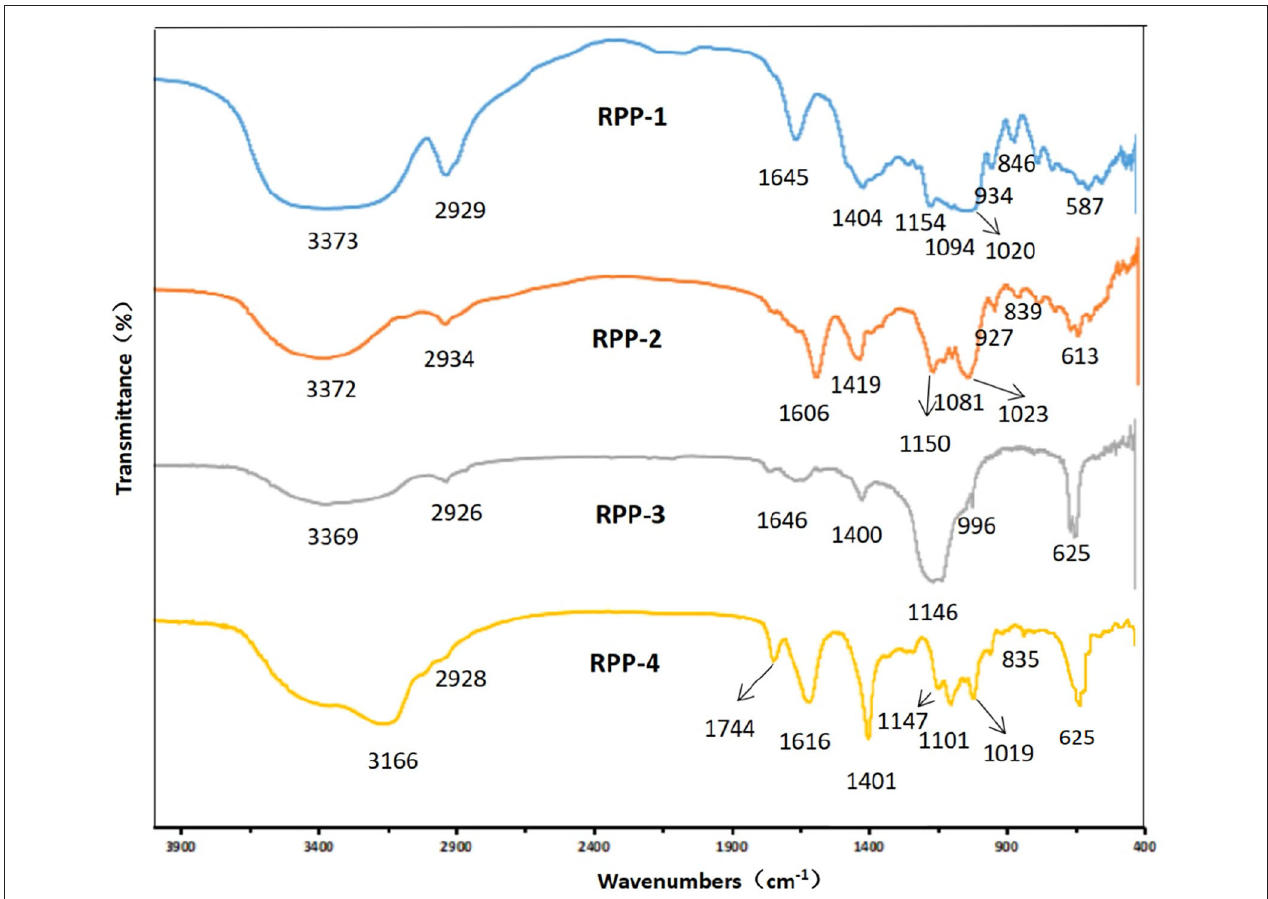
FIGURE 3 | Fourier transform infrared (FT-IR) spectrum of RPPs. RPPs, refined pumpkin polysaccharides. Deproteinized pumpkin polysaccharides were separated in DEAE-52 cellulose gel column to obtain RPP-1, RPP-2, RPP-3, and RPP-4. RPP-1 was a neutral polysaccharide, while RPP-2, RPP-3, and RPP-4 were all acidic